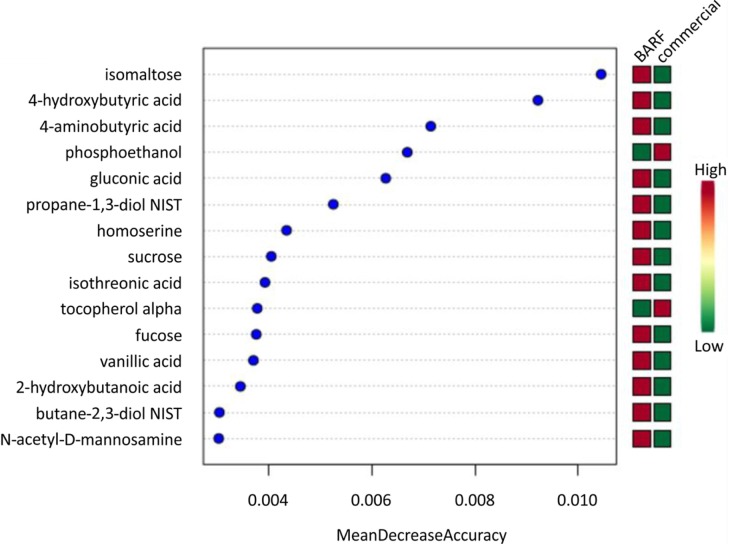
Random forest analysis.Top 15 metabolites with the highest discriminatory power between both diet groups are listed. Red fields show a high abundance, green fields a low abundance of the particular metabolite based on diet.